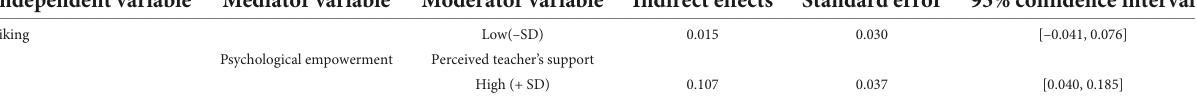
TABLE 5 Bootstrap test of moderated mediating